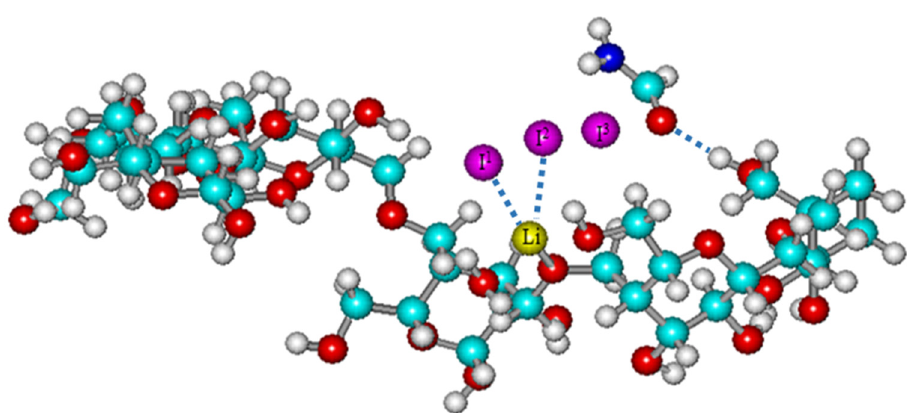
Figure 2. Complex I, LiI-I 2 in the dextrin ring. blue balls—carbon atoms, red—oxygen, dark blue—nitrogen, violet—iodine, yellow—lithium ion, white balls—hydrogen atoms.